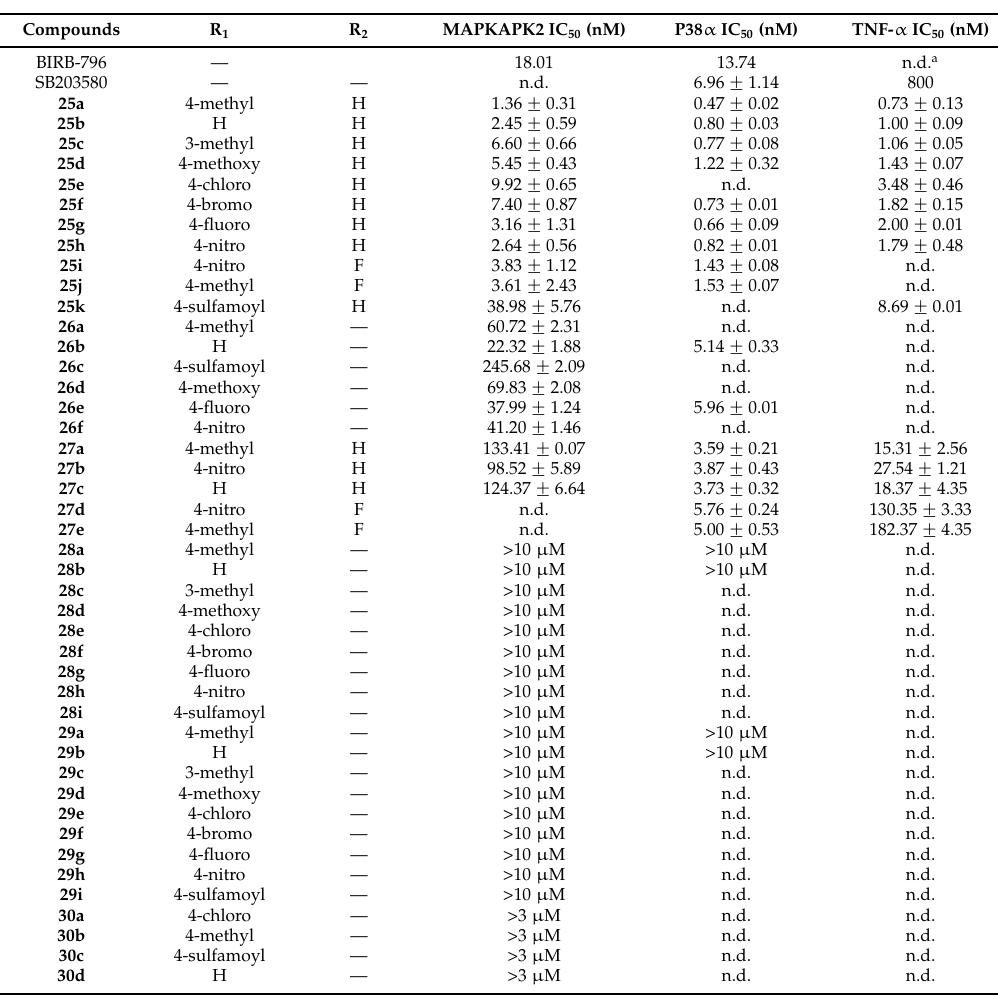
Table 1. MAPKAPK2, p38 α and TNF- α activity data for small molecule inhibitors.